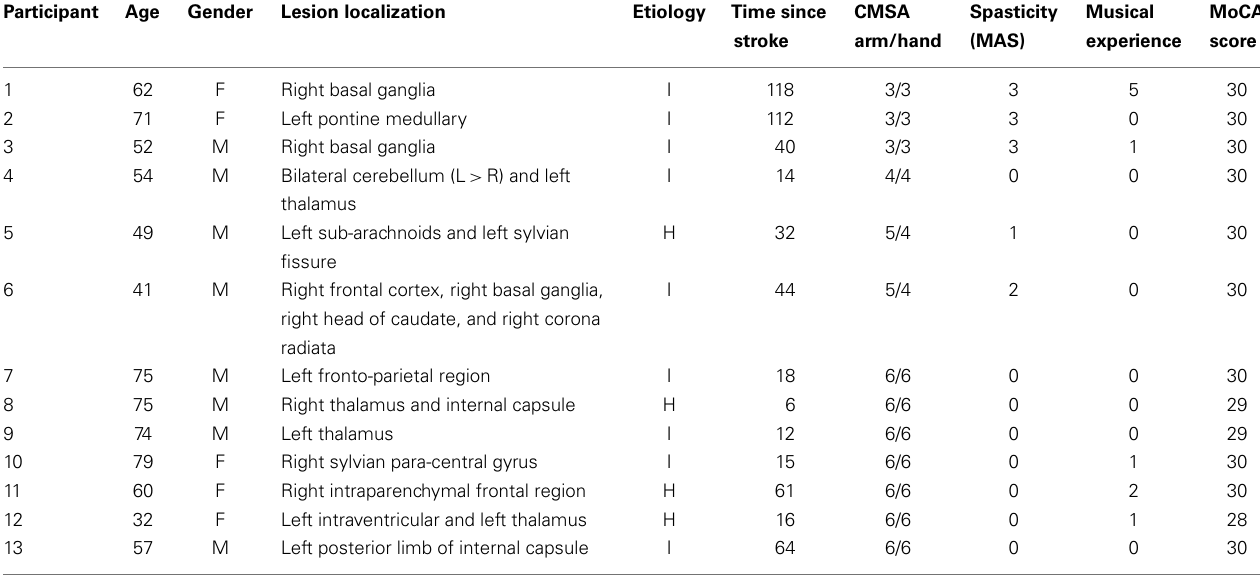
Table 2 | Participant characteristics at baseline